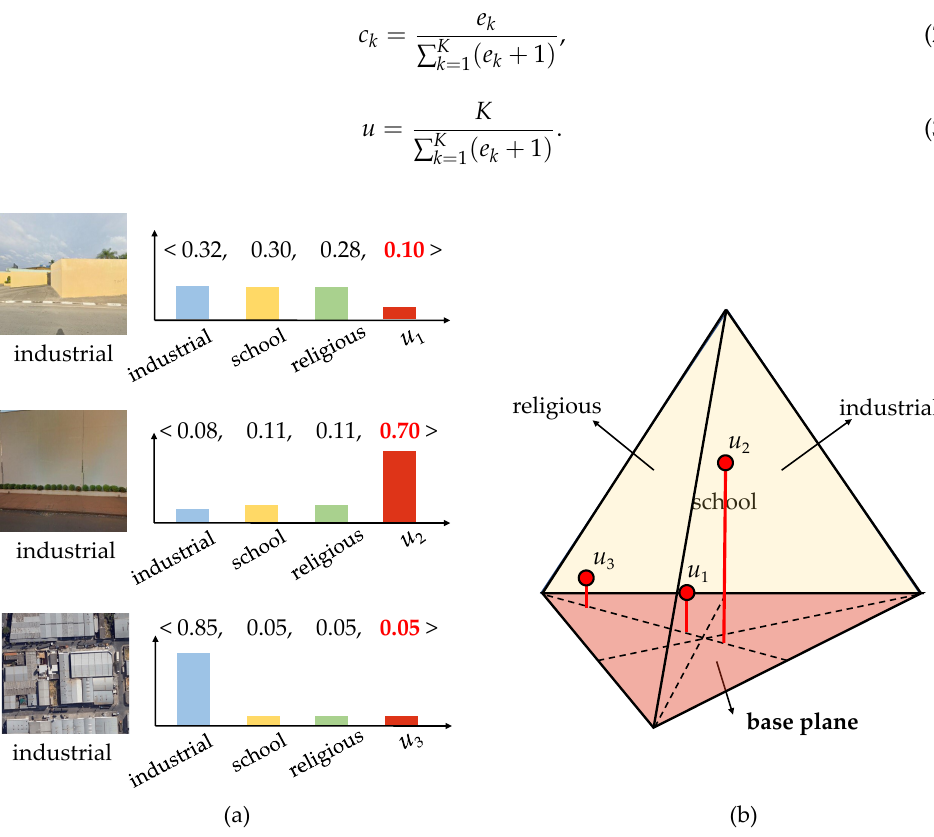
Figure 6. A multi-classification case of the proposed uncertainty estimation operation: ( a ) shows the “opinions” of three samples (two ground view image and one aerial image); ( b ) is the Opinion tetrahedron with example